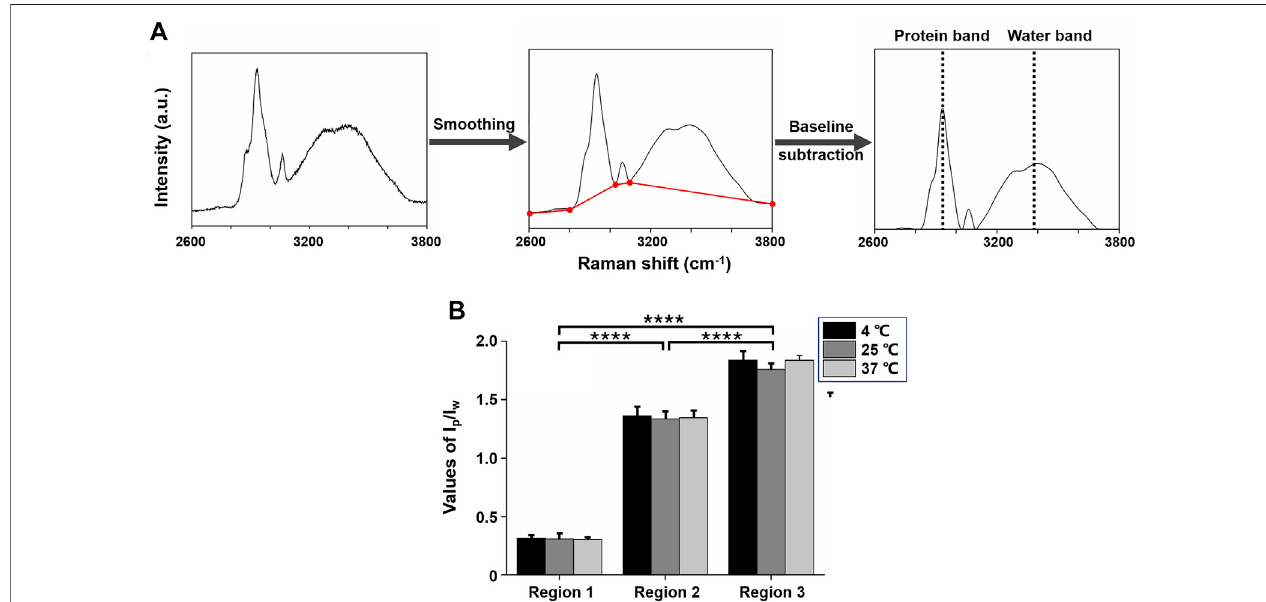
FIGURE 3 | High-wavenumber Raman spectra (2,600 – 3,800 cm − 1 ) of mice lens. (A) Spectra processing procedure. (B) : Average ratios of the intensity of protein and water brands (I p /I w ) for three regions from all three lenses treated with different temperatures. I p /I w values increased from regions 1 to 3 and showed statistically signi fi cant differences between each region at 4 ° C, 25 ° C, and 37 ° C (**** p ≤